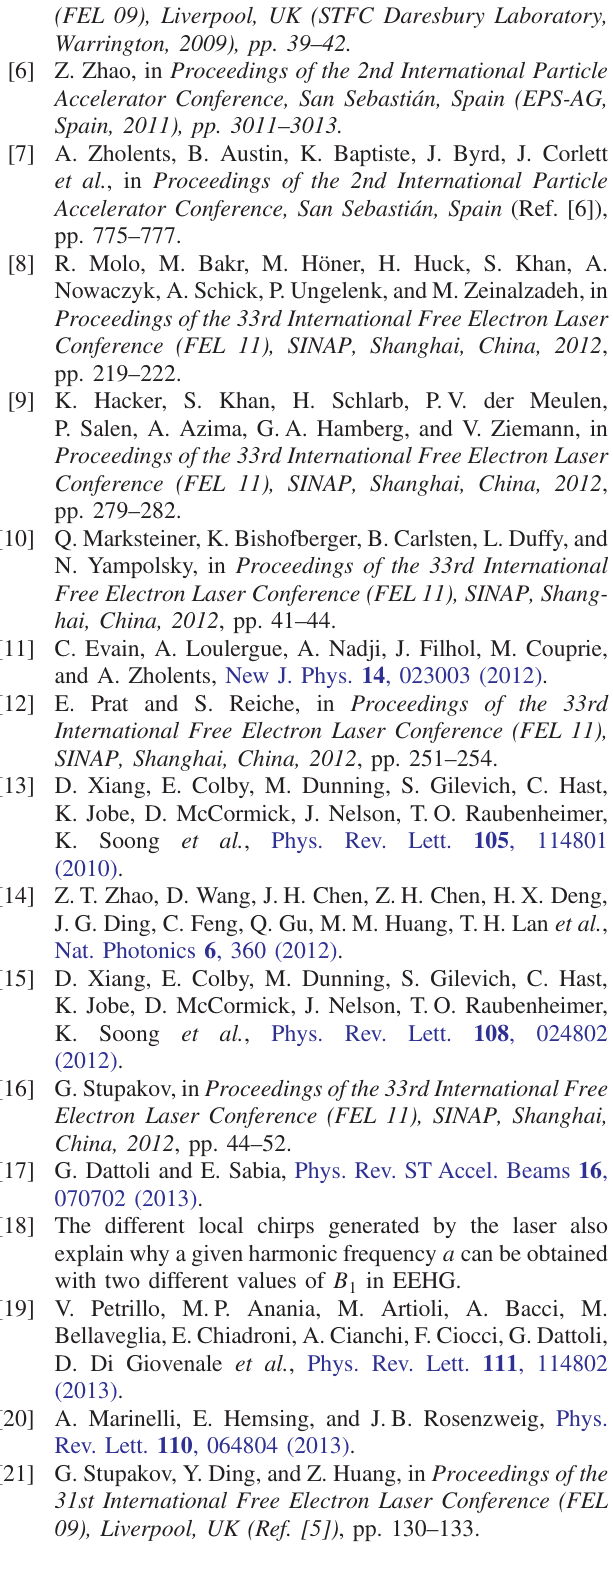
ffiffiffi p 2 . A similar